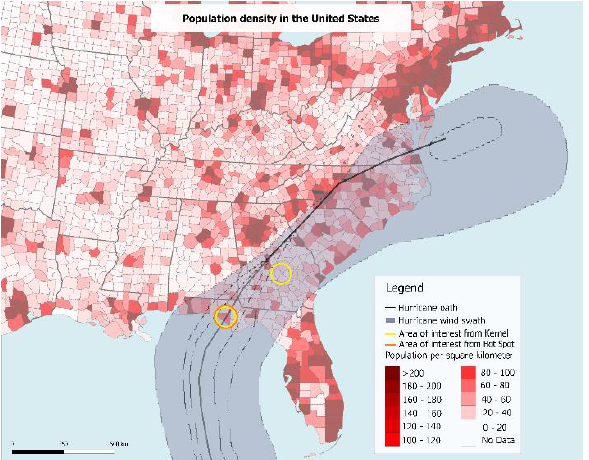
Figure 3. Population density in the United States in 2010 (yellow circles and the orange circle show areas with high impact detected respectively by Kernel Density and by Hot spot analysis) Figure 5. An overview of the populated area near Douglas and Twitter posts highlighted by the Kernel density